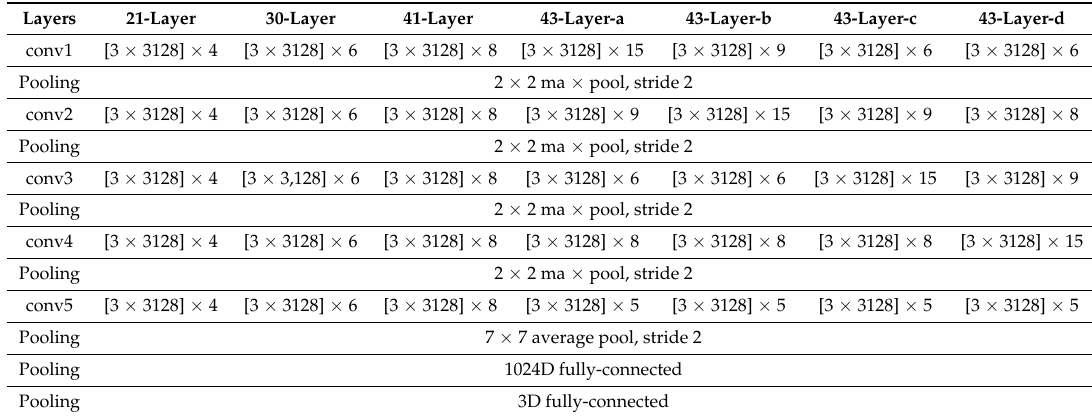
Table 3. Configuration of the experiment of the convolution layers.